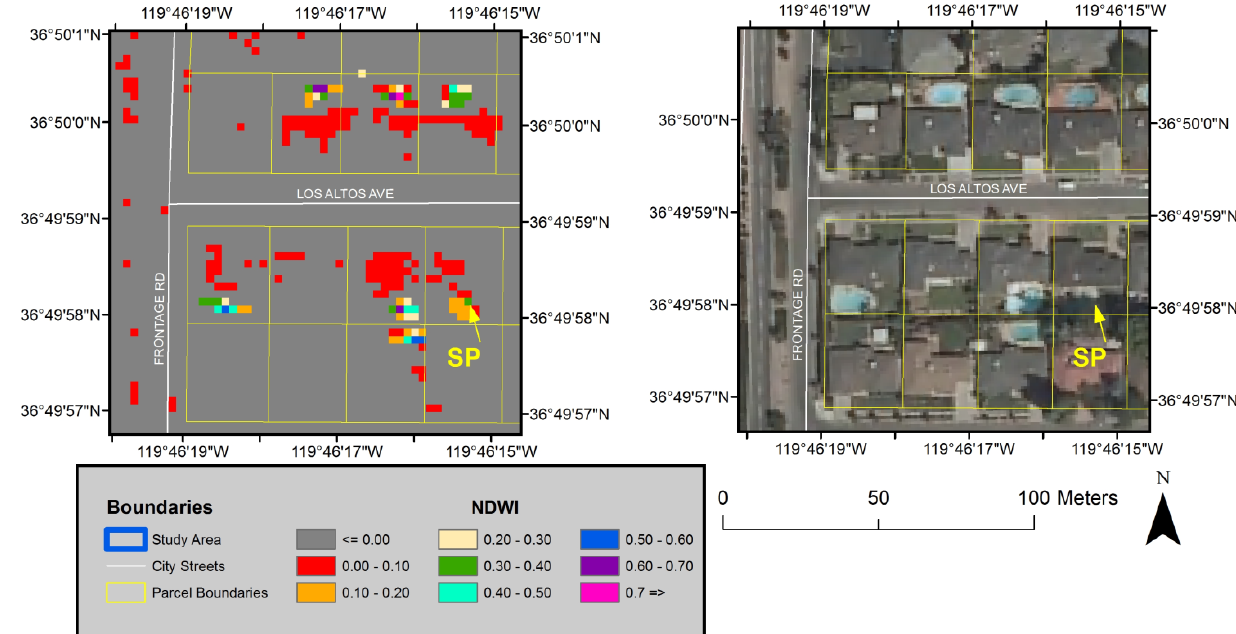
Figure 4. Color-coded NDWI image of residential neighborhood ( left ). True color NAIP image acquired on 27 June 2009 ( right ). Low NDWI values are easily associated with non-water features such as rooftops and asphalt roads. The feature in both images labeled SP (shaded pool) is an example of where shadowing effects can cause low NDWI values for water surfaces. Note the large number of low value NDWI pixels associated with some